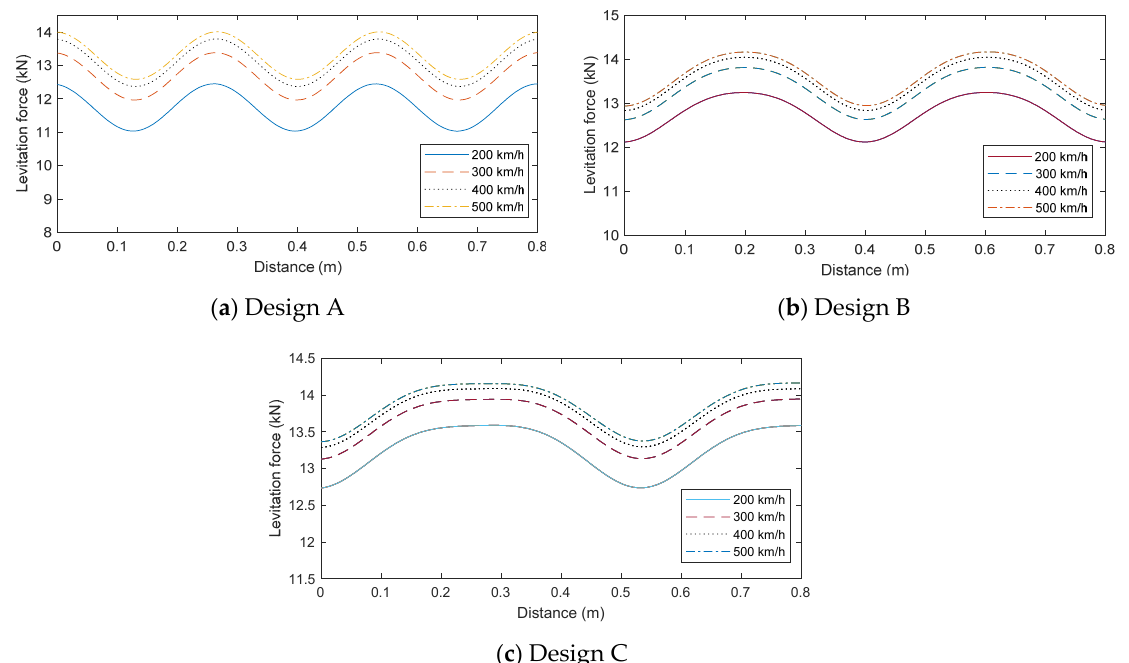
Figure 6. Variation in the levitation force with respect to vehicle